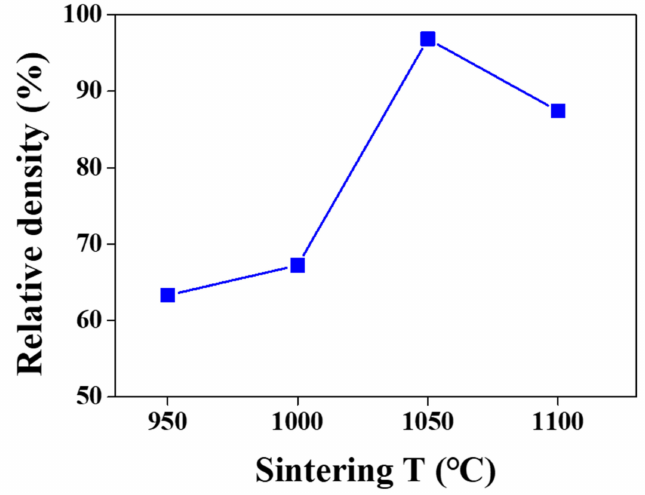
Figure 5. Relative densities of pellets at various sintering